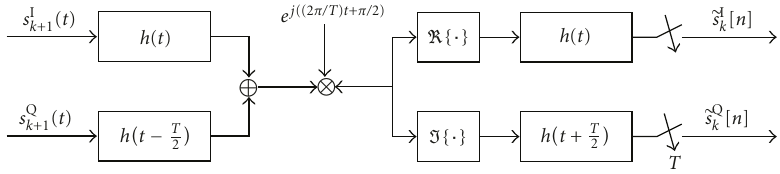
Figure 8: The k th subcarrier channel in an SMT